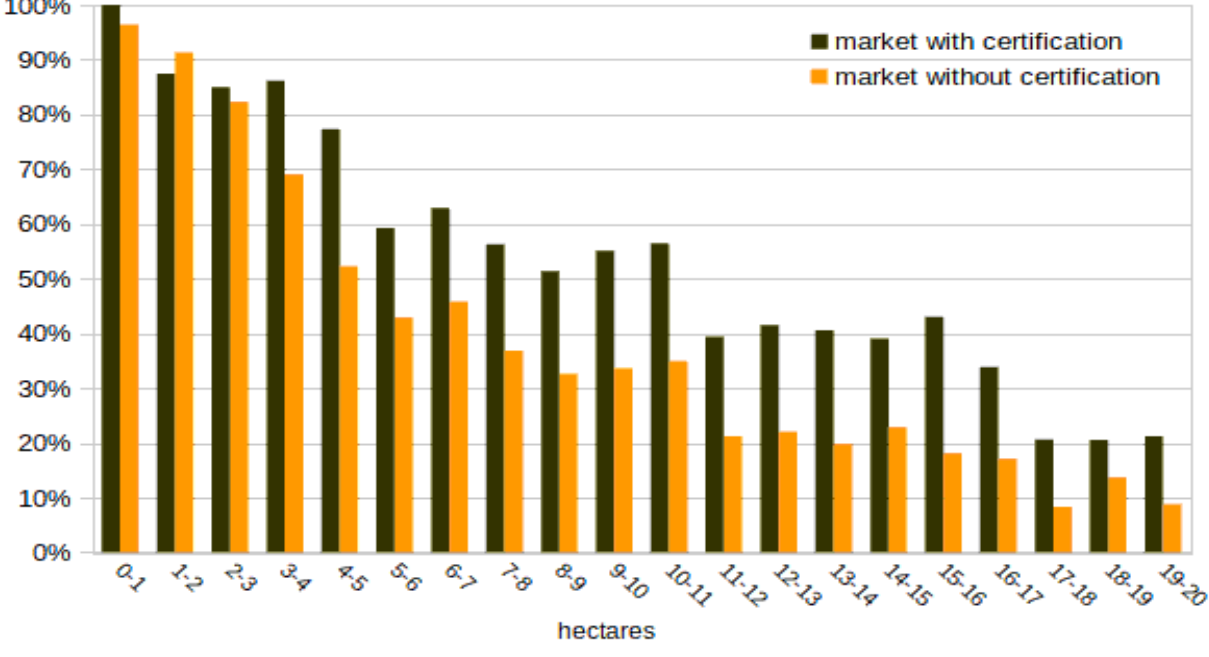
Figure 3. Incidence of ceased farms, according to their size.